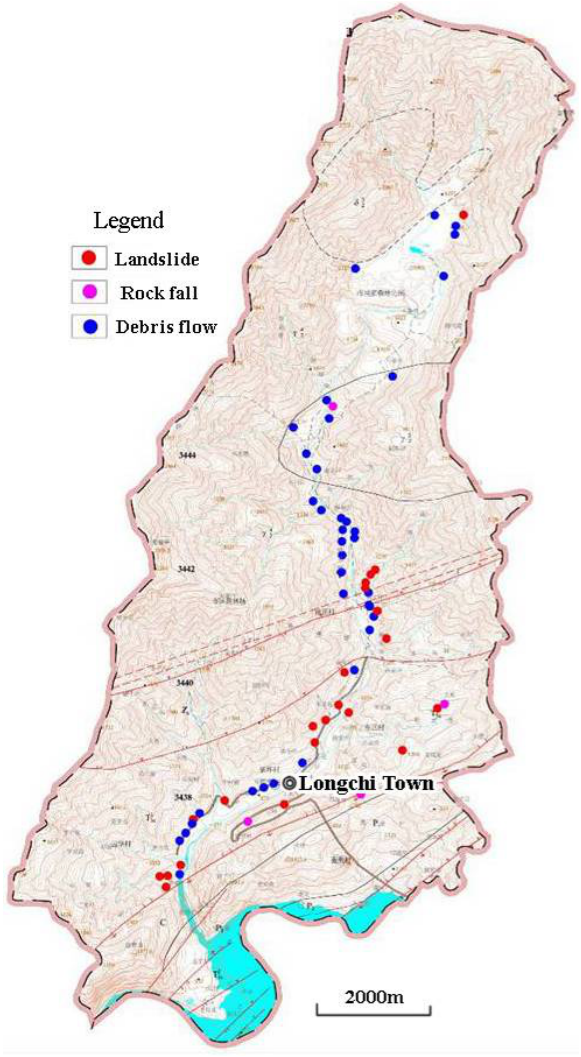
Fig. 15. The new geo-hazards triggered by the rainstorm on August 13, 2010 along the Longxi River.